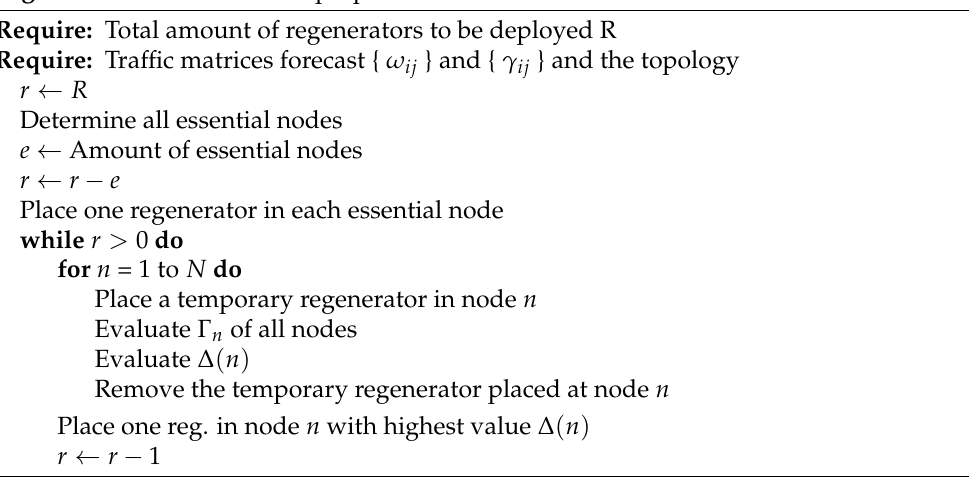
Algorithm 1 Pseudocode for proposed